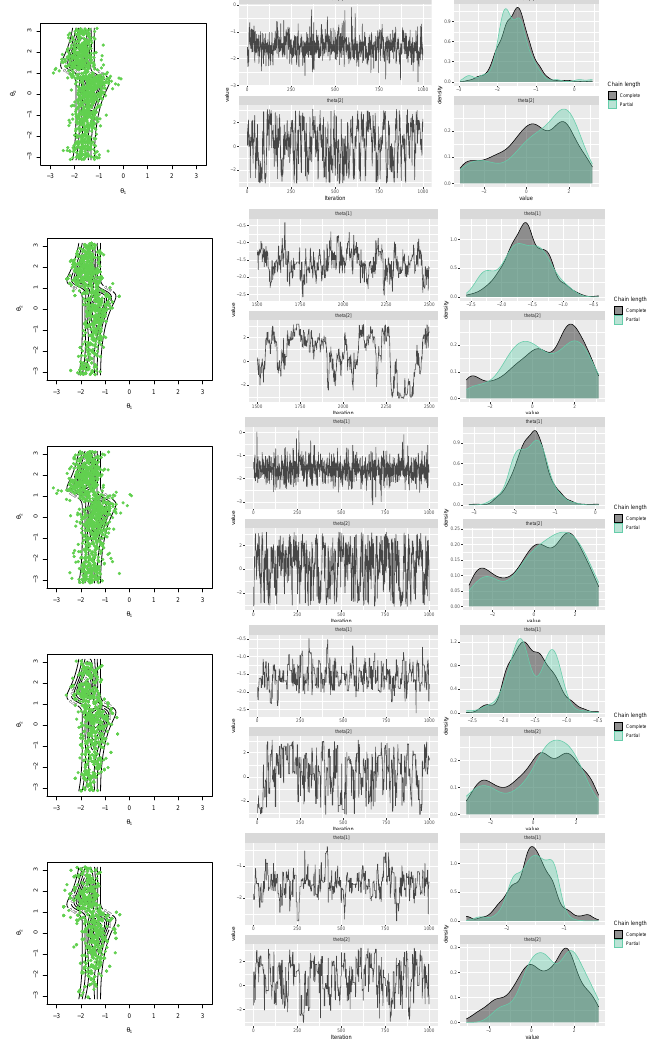
Figure 15. Scatter, trace, and compare-partial plots of the simulated data from the transformed cosine model using “gibbs_met” in the “gibbs.met” package (first row), “MCMCmetrop1R” in the “MCMCpack” package (second row), “met_gaussian” in the “gibbs.met” package (third row), “Metro_Hastings” in the “MHadaptive” package (fourth row), and “rwmetrop” in the “LearnBayes” package (fifth